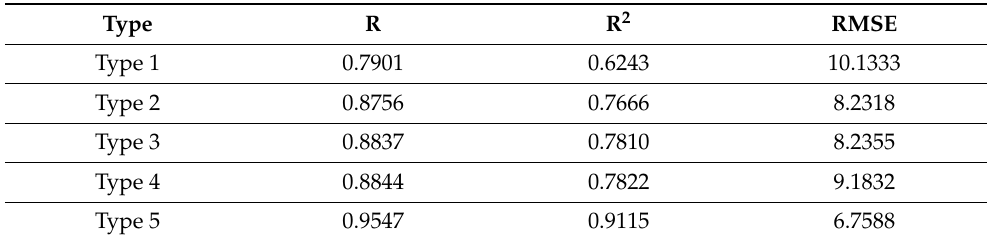
Table 12. Regression analysis results of equations for predicting the ultimate axial strain of the concrete cylinders confined with SMA spirals.